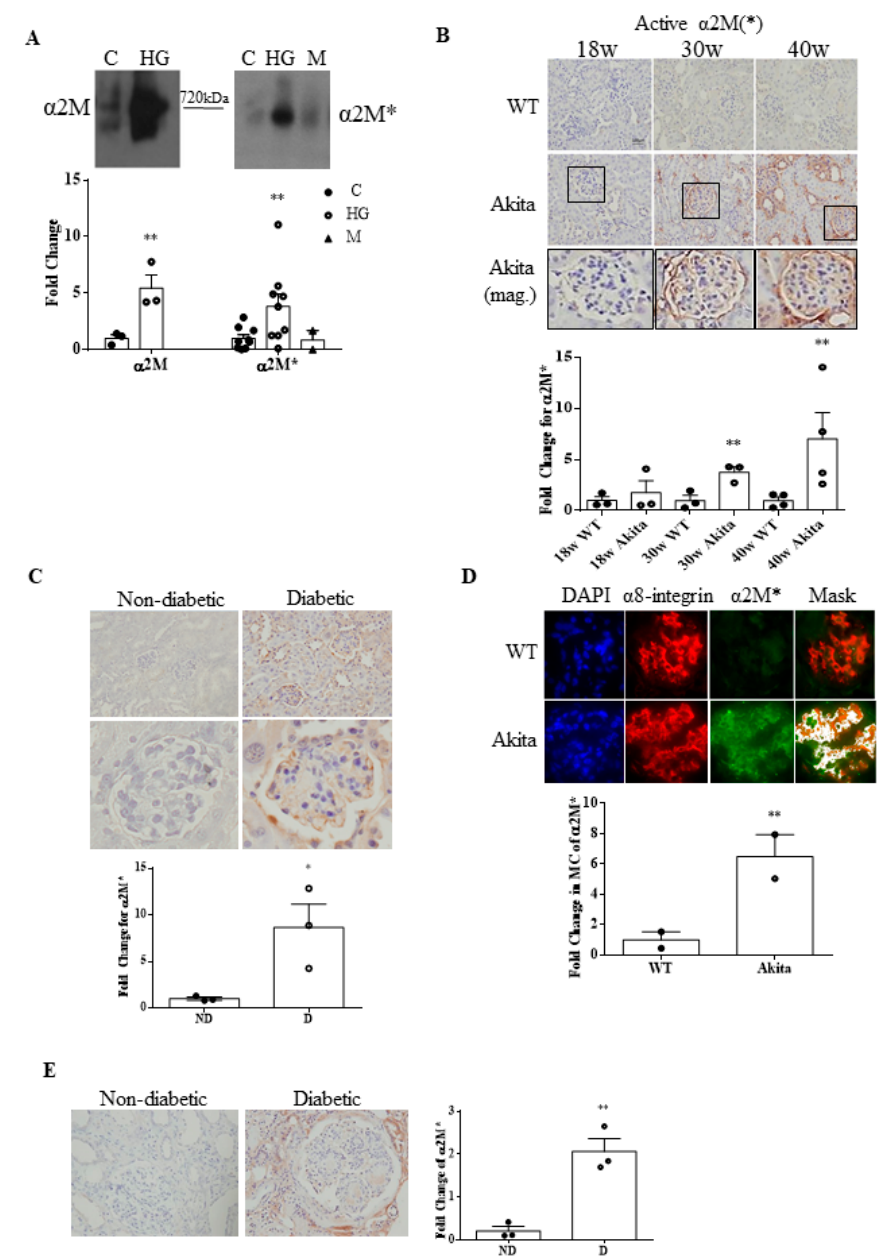
Figure 2. Activated α 2M ( α 2M*) is increased by HG in mesangial cells and in diabetic kidney mesangium. ( A ) High glucose (HG, 48 h) increased media expression of α 2M (left) and α 2M* (right) in MCs, seen using a nondenaturing gel. Activated α 2M migrates faster on a non-denaturing gel compared to its inactive form. The osmotic control mannitol (M) had no effect ( n = 3) (** p < 0.05 vs. its own control). ( B ) α 2M* expression was significantly higher in kidney sections from type 1 diabetic Akita mice compared to wild-type mice at 30 and 40 weeks of age (40 × magnification, n = 10 each, ** p < 0.05 vs. respective control). ( C ) α 2M* expression was also significantly higher in uninephrectomized type 1 diabetic CD1 mice compared to their non-diabetic controls (40 × magnification, n = 3, * p < 0.01 vs. control group). ( D ) α 2M* colocalization with mesangial cells, identified by their marker α 8-integrin, was significantly higher in kidney sections from type 1 diabetic Akita mice compared to wild type mice at 40 weeks of age (40 × magnification, n = 2, 20 glomeruli per section) (** p < 0.05 vs. respective control). ( E ) α 2M* expression in human biopsy samples from DKD patients was significantly higher compared to control kidneys (40 × magnification, n = 4) (** p < 0.05 vs. control